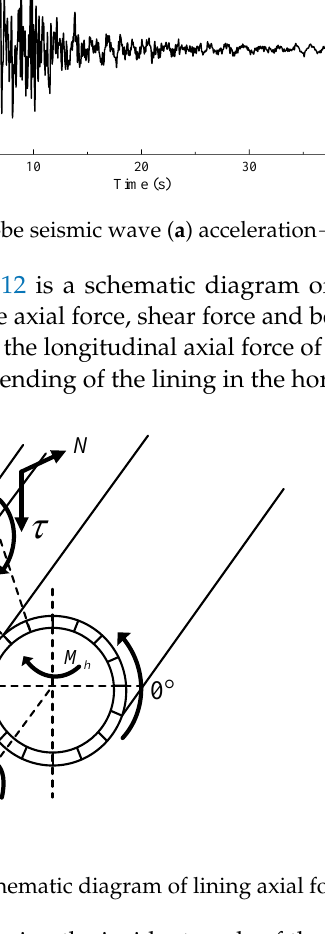
angle, are obtained. When the P wave is incident, as shown in Figure 13a, M c